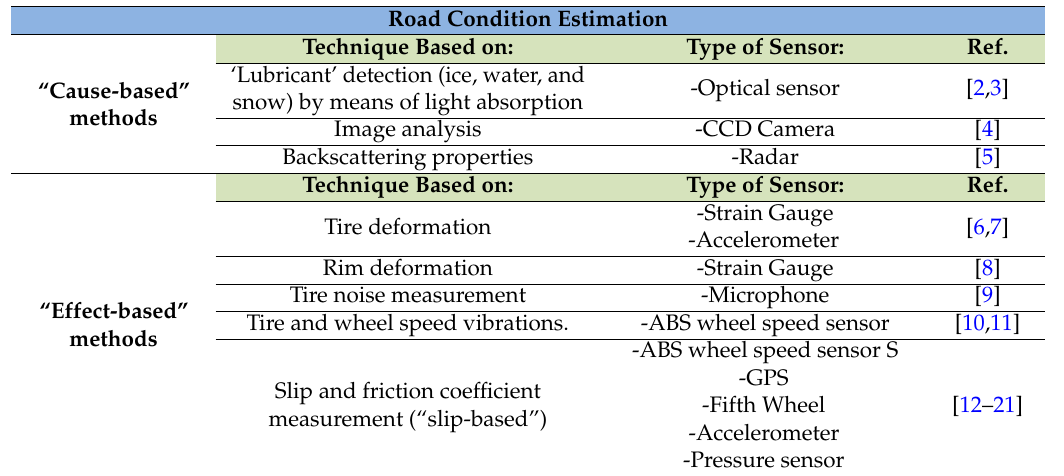
Table 1. Summary of different methodologies to determine the road